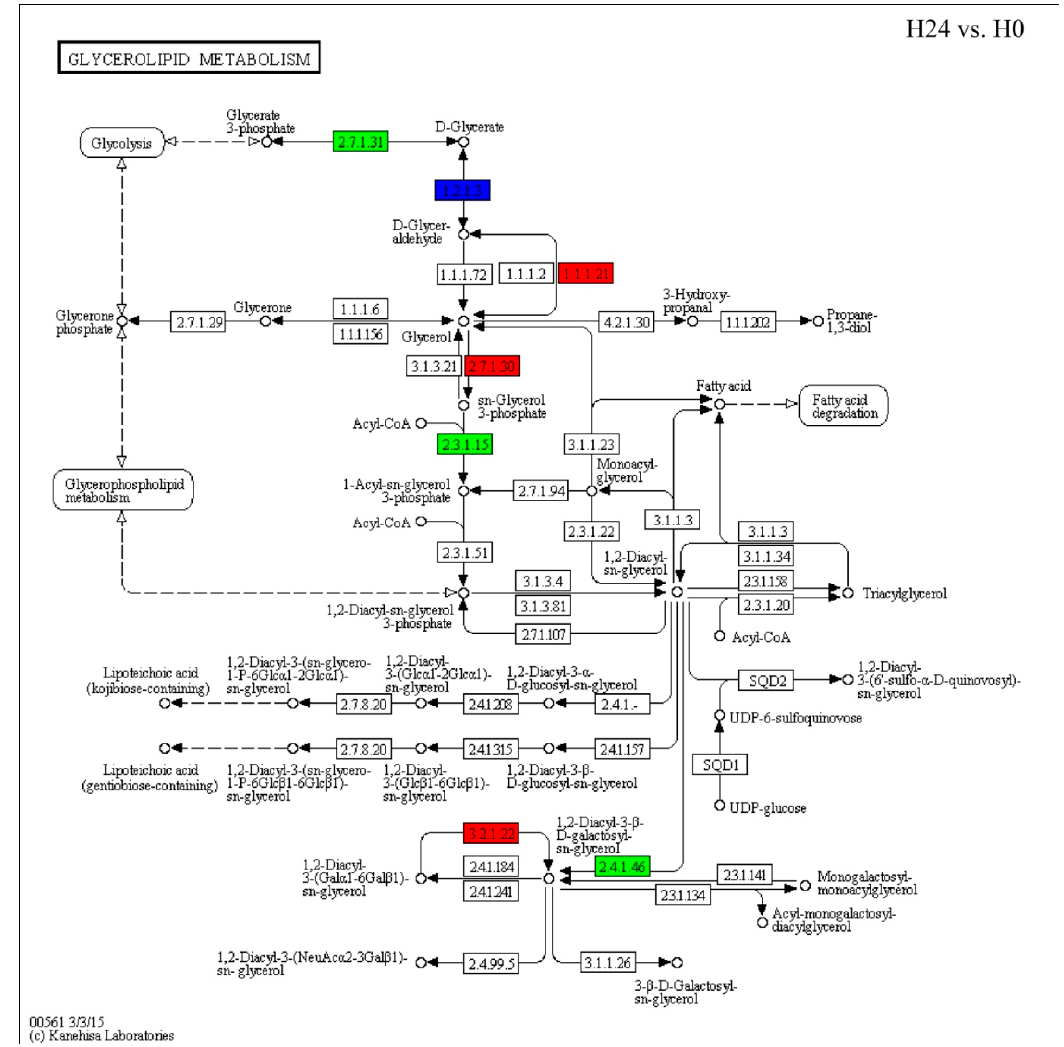
Figure 3. Gene expressions in the glycerolipid metabolism pathway (Ko00561) in response to Bgt infection. The red color indicates gene expression induction in H24 group; the green color indicates gene expression reduction in H24 group; the blue color indicates that the expression patterns of some annotated genes were induced and some homologous genes were reduced in H24 group.